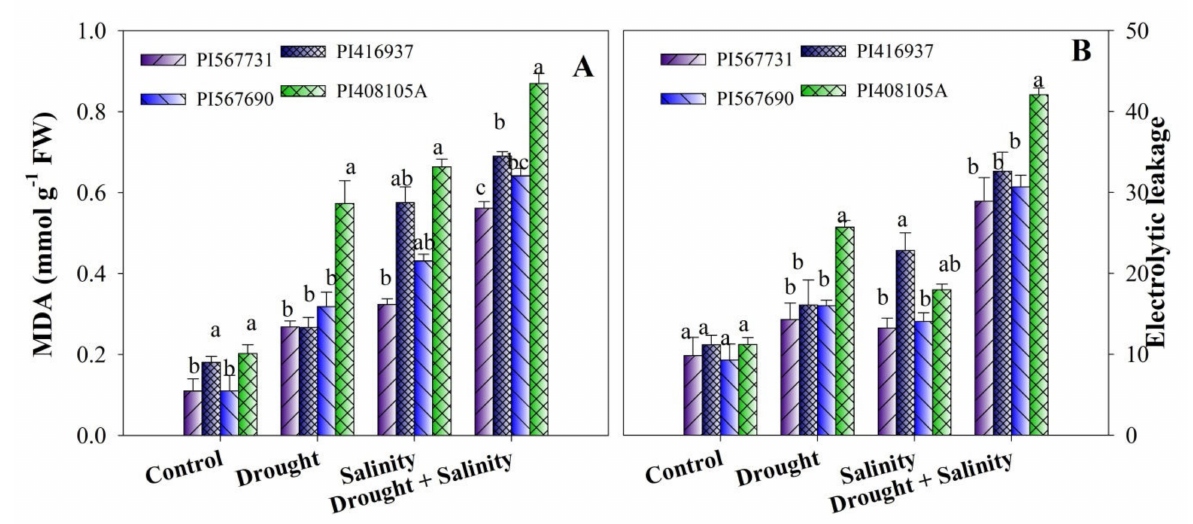
Figure 7. ( A ) Lipid peroxidation and ( B ) electrolyte leakage of four soybean cultivars grown under drought and salinity stress conditions. Data presented are means ± SD, and different letters denote a significant difference at p < 0.05 based on the least significant difference (LSD) test. Letter a is highly significant than b, and ab means no significant differences between a with ab and b with